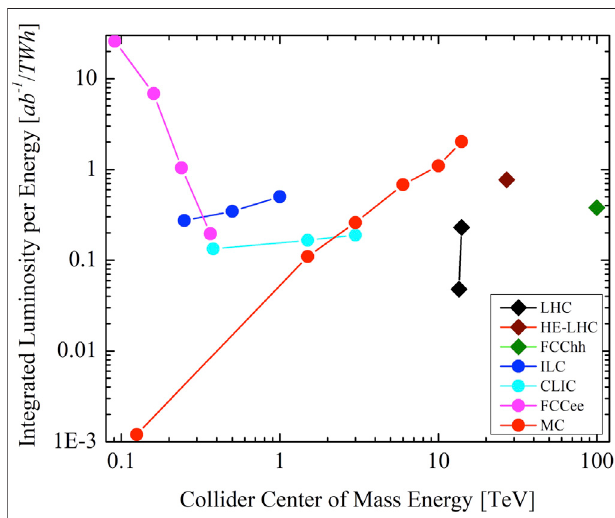
FIGURE 1 | Energy ef fi ciency of present and future colliders. Annual integrated luminosity per Terawatt-hour of electric power consumption as a function ofthe centre-of-massenergy. The LHC — both presentand expected afteritshigh-luminosityupgrade(blackdiamonds) — iscontrastedwitha variety of proposed particle colliders: the Muon Collider (MC, red circles), the Future Circular electron — positron Collider (FCC-ee, magenta circles) assuming experiments at two collision points, the International Linear Collider (ILC, blue circles), the Compact Linear Collider (CLIC, cyan circles), the High Energy LHC (HE-LHC, magenta diamonds), and the Future Circular proton – proton Collider (FCC-hh, green diamonds). For lepton and hadron colliders operating at the sameCOM energy, the energy reach of the former is typically larger, by factors that depend, process by process, on the nature of the produced particles and their